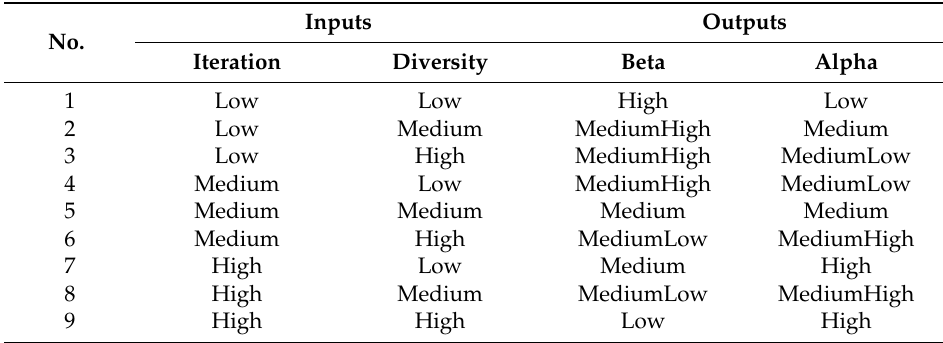
Table 1. Fuzzy rules for dynamic Beta and Alpha.